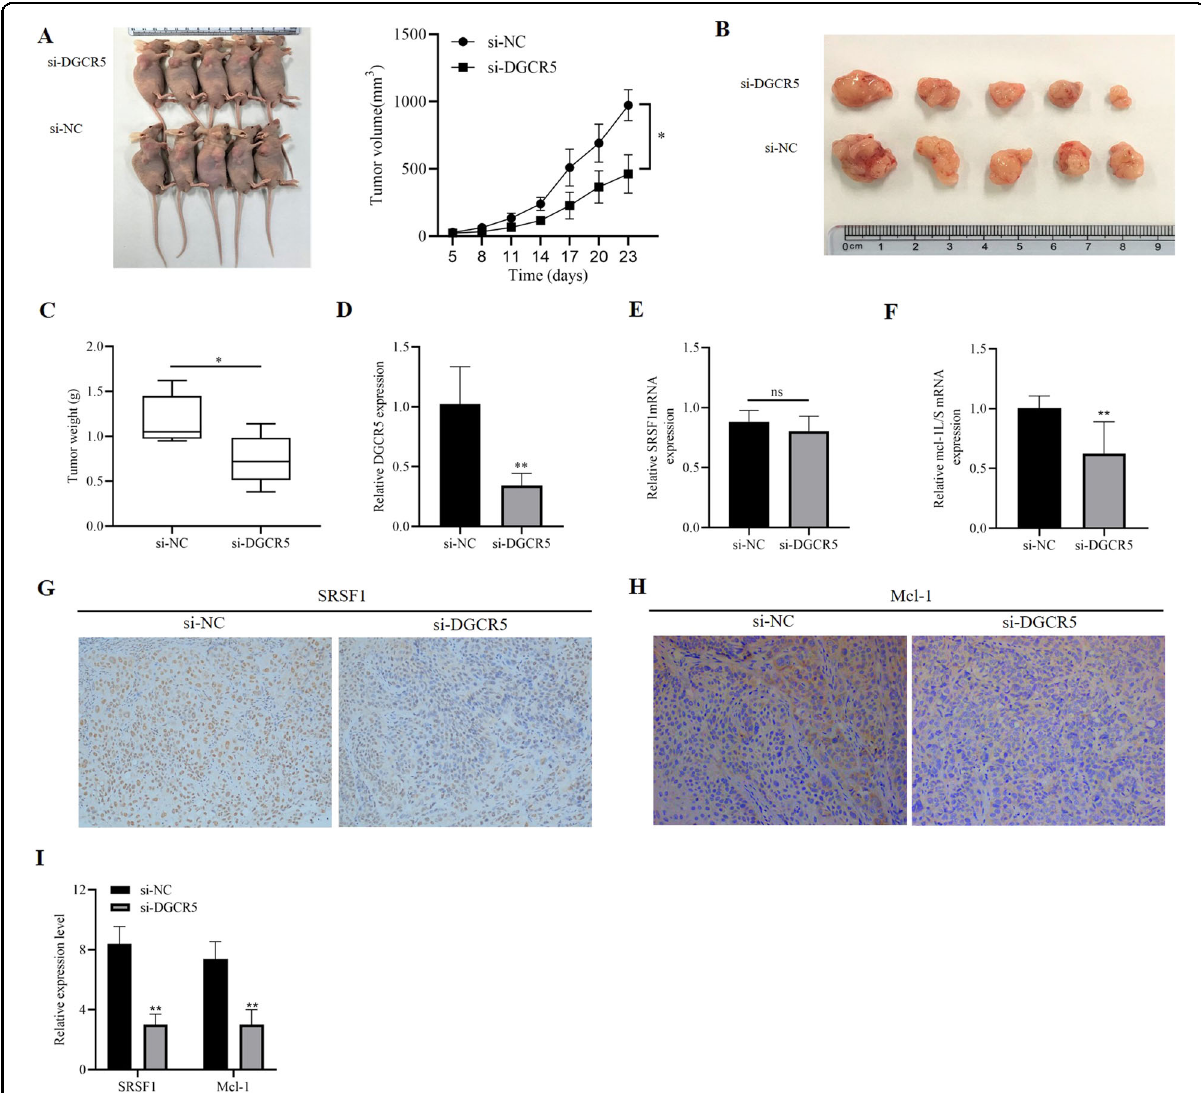
Fig. 6 DGCR5 promotes tumor growth in vivo. A In total, 4 × 10 6 Kyse170 cells with si-NC or si-DGCR5 were injected into 5-week-old nude mice subcutaneously. B , C Weight of subcutaneous xenograft tumors of Kyse170 cells were measured every 3 days, DGCR5 knockdown delayed tumor weight. D – F Expression level of DGCR5, SRSF1, and Mcl-1 was separately detected by qRT-PCR. G – I SRSF1 and Mcl-1 expression was measured in tumor tissues by IHC. Original magni fi cation ×200. * P < 0.05 and ** P <